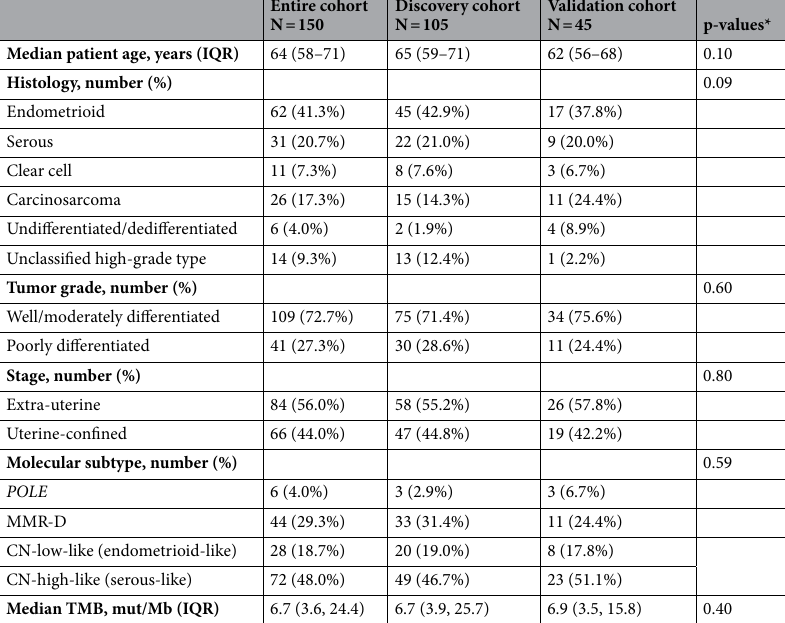
Table 1. Patient characteristics. IQR interquartile range, FIGO the International Federation of Gynecology and Obstetrics, POLE polymerase epsilon, MMR-D DNA mismatch repair-deficient, CN copy number, TMB tumor mutational burden, mut/Mb mutations per megabase. *Categorical variables were compared using Fisher exact test; continuous variables were compared with Mann–Whitney U-test.